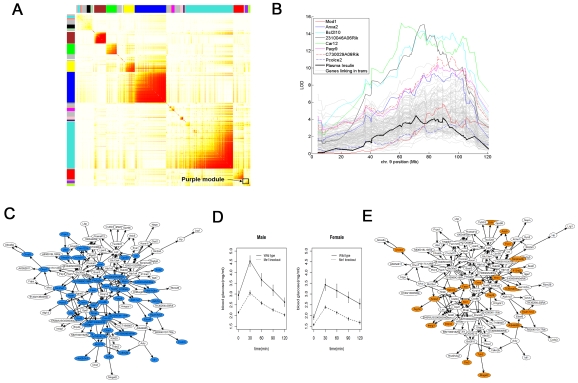
Adipose T2D causal subnetwork and human supporting evidence.A) The adipose coexpression network is comprised of 9,900 gene expression traits. The purple subnetwork comprised of 159 genes is highlighted as the subnetwork most enriched for genes supported as causal for T2D. B) LOD score plots for plasma insulin (solid black), Me1 adipose expression (solid red), Anxa2 adipose expression (solid blue), Bcl2l10 adipose expression (solid cyan), 2310046806Rik adipose expression (solid black), Car12 adipose expression (solid green), Paqr9 adipose expression (solid magenta), C730029A08Rik adipose expression (dashed red), Poclce2 adipose expression (dashed blue), and adipose expression traits linking to this region in trans (grey), all measured in the B6×BTBR cross. C) The T2D adipose causal subnetwork is enriched for genes supported as having a causal relationship with plasma insulin levels in the B6×BTBR cross (blue nodes). The white nodes represent genes in the T2D adipose causal subnetwork not supported as causal for insulin traits in the B6×BTBR cross. D) OGTT curves for Me1−/− (Male n = 19; Female n = 14) and wild-type control (Male n = 25; Female n = 16) mice (p = 3.16×10−4 for male OGTT AUC and p = 1.84×10−3 for female OGTT AUC; overall sex adjusted difference p = 7.30×10−8). E) The T2D adipose causal subnetwork is enriched for genes in the Me1−/− adipose gene expression signature (orange nodes). The white nodes represent genes in the purple subnetwork not in the Me1−/− adipose gene signature.